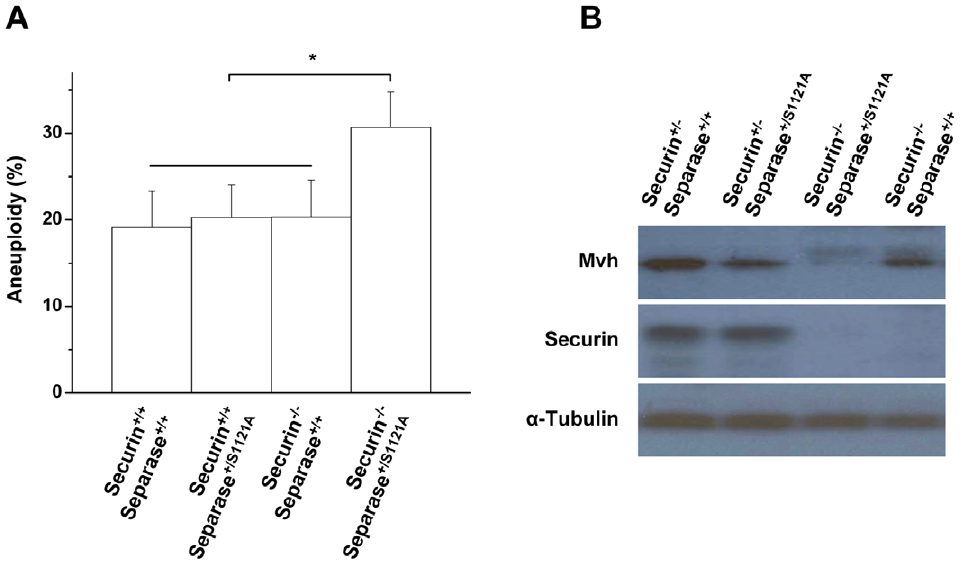
Figure 6. Securin expression is correlated to Separase-mediated defects. A. Quantitative analysis of karyotyping of the four types of ES cells (n=3) (* p , 0.05, T test). B. Western blot detection of Mvh and Securin of urogenital ridges at 10.5 dpc.